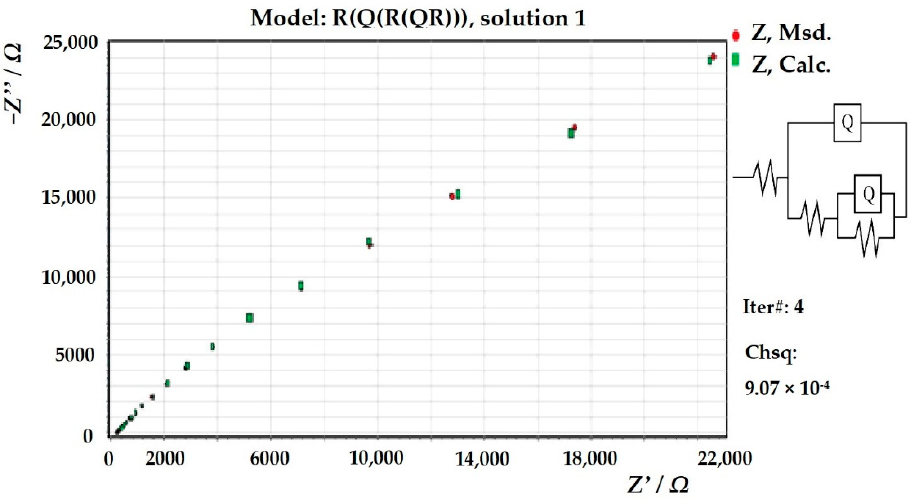
Figure 5. Modelling of Nyquist’s EIS diagrams obtained for HTCS-130 tool steel in solution 1. Table 3 lists the obtained impedance Table 3 lists the obtained impedance parameters. Table 3. Impedance parameters of the tested HTCS-130 tool steel.